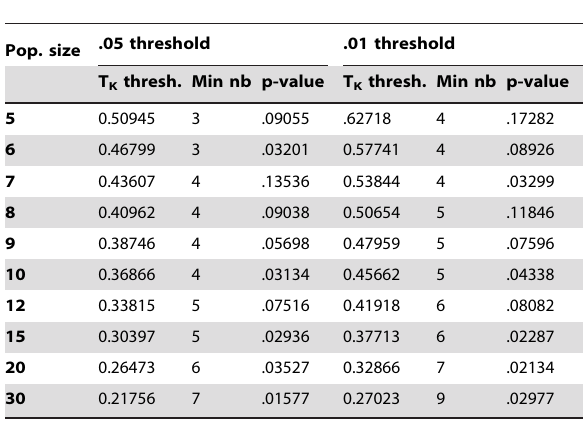
Table 1. UKS test thresholds and associated p-value limits.